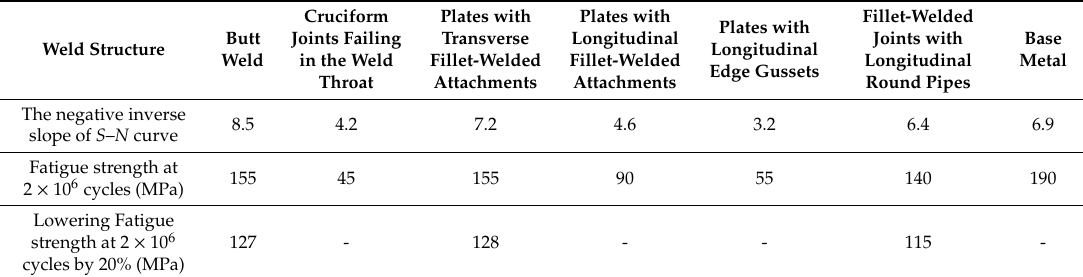
Table 4. The fatigue strength of welded joints of stainless steel suggested in this